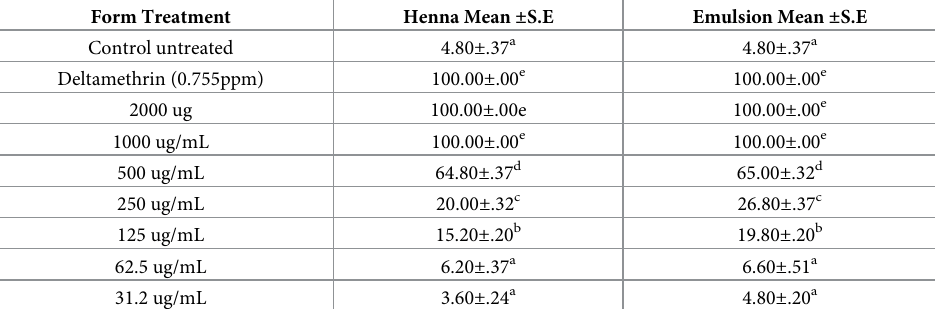
Superscript of the same letter in cells of the same column shows a non-significant effect in respect to the non-treated control. Superscript of different letters in cells of the same column shows a significant effect in respect to the non- treated control ( P �